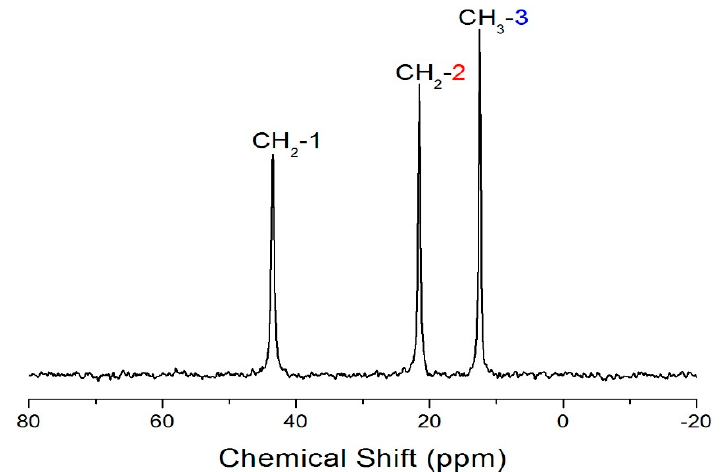
Figure 4. 13 C CP/MAS NMR spectrum of (CH 3 CH 2 CH 2 NH 3 ) 2 CdCl 4 at 300 K.